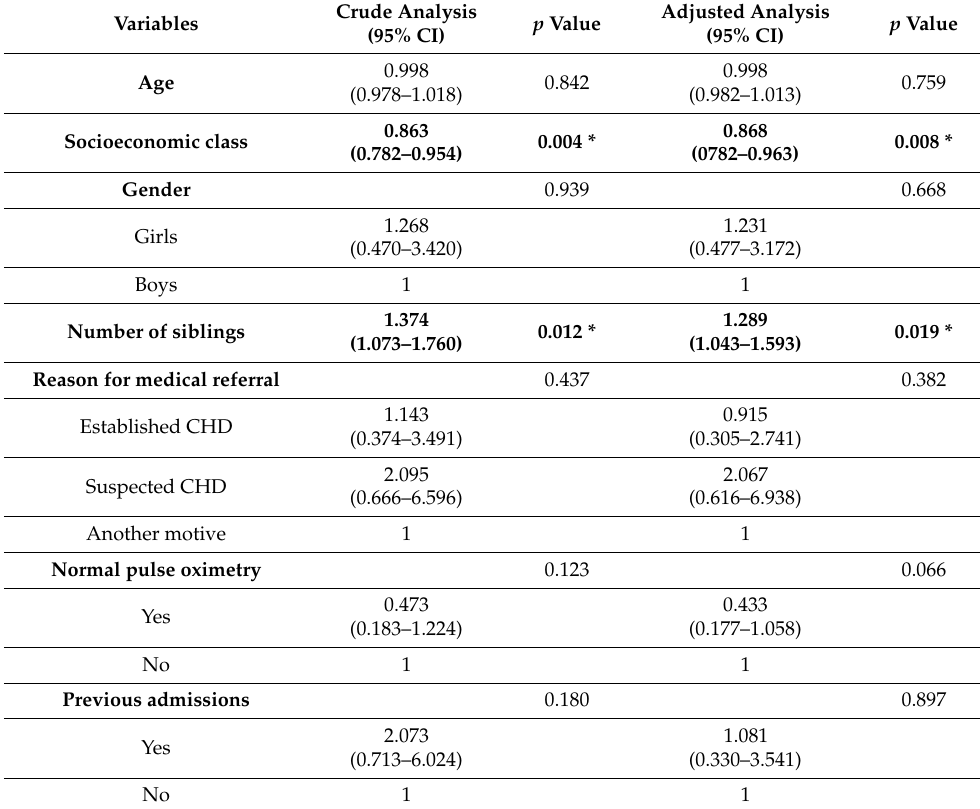
Table 5. Crude and adjusted analyses of risk factors related to attention